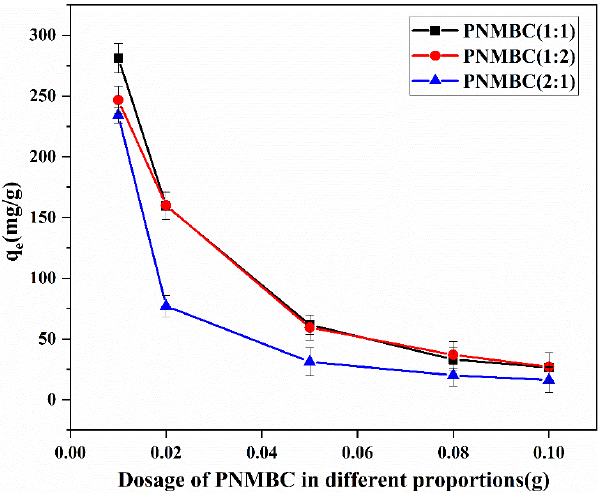
Figure 8. Effect of PNMBC biosorbent dosage on the adsorption of Cu( Ⅱ ).